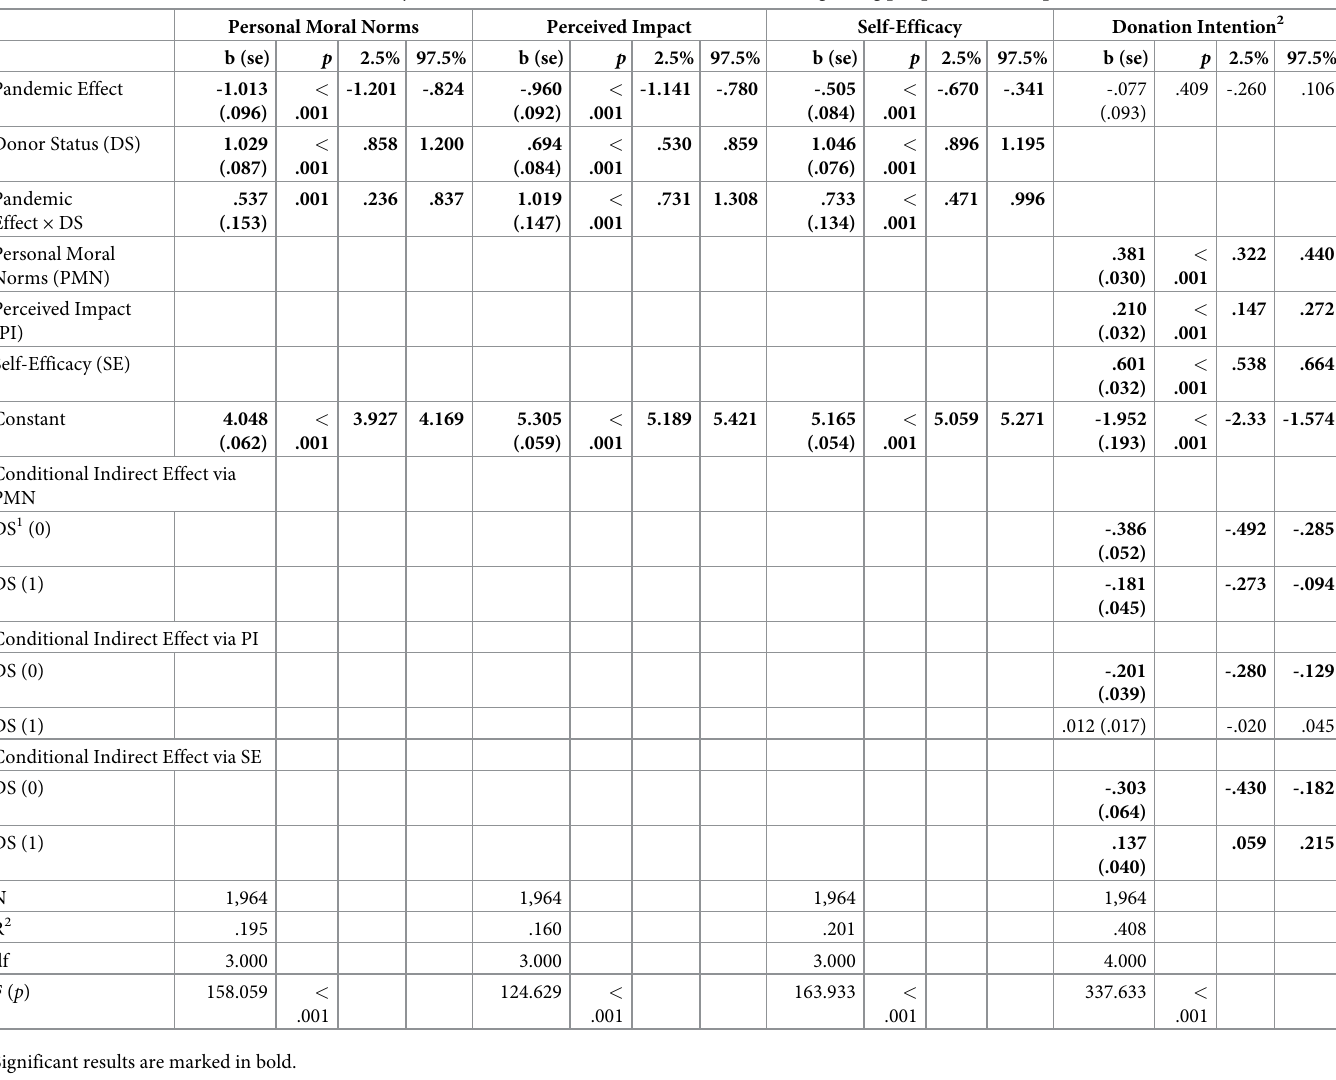
Table 2. Results of the moderated mediation analysis on donation intentions in the medium term regarding pre-pandemic and pandemic (t =